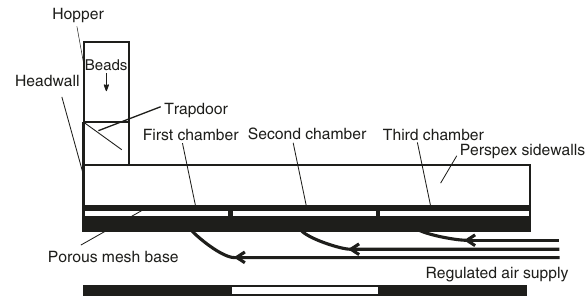
Fig. 9 A longitudinal section view of the experimental fl ume. Scale bar